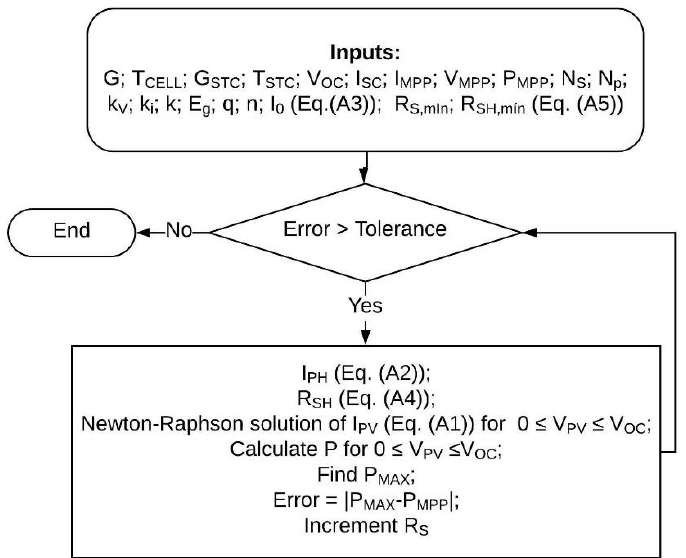
Figure A1. Flowchart with the algorithm to find R S and R SH . In Figure A1, the algorithm stops the iteration when the difference between the maximum calculated power ( P MAX ) and the maximum power from the manufacturer’s data sheet ( P MPP ) is zero or less than the